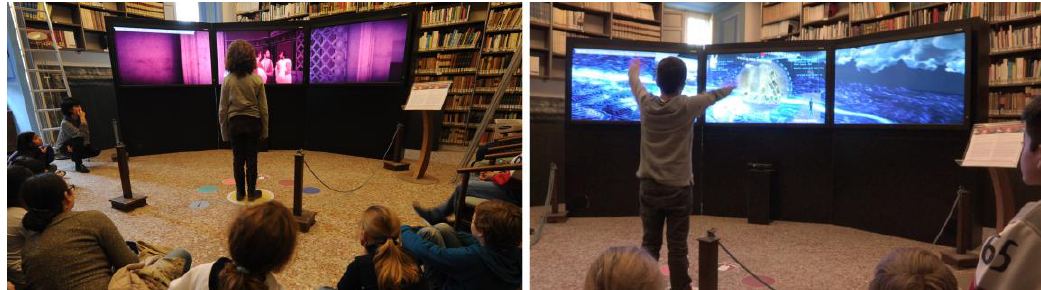
Figure 2. Virtual Museum of the Tiber Valley, VR with gesture-based interaction, here presented in Villa Celimontana in Rome in 2014. The permanent installation is at the National Etruscan Museum of Villa Giulia, Rome. Realized by CNR ITABC in 2014.